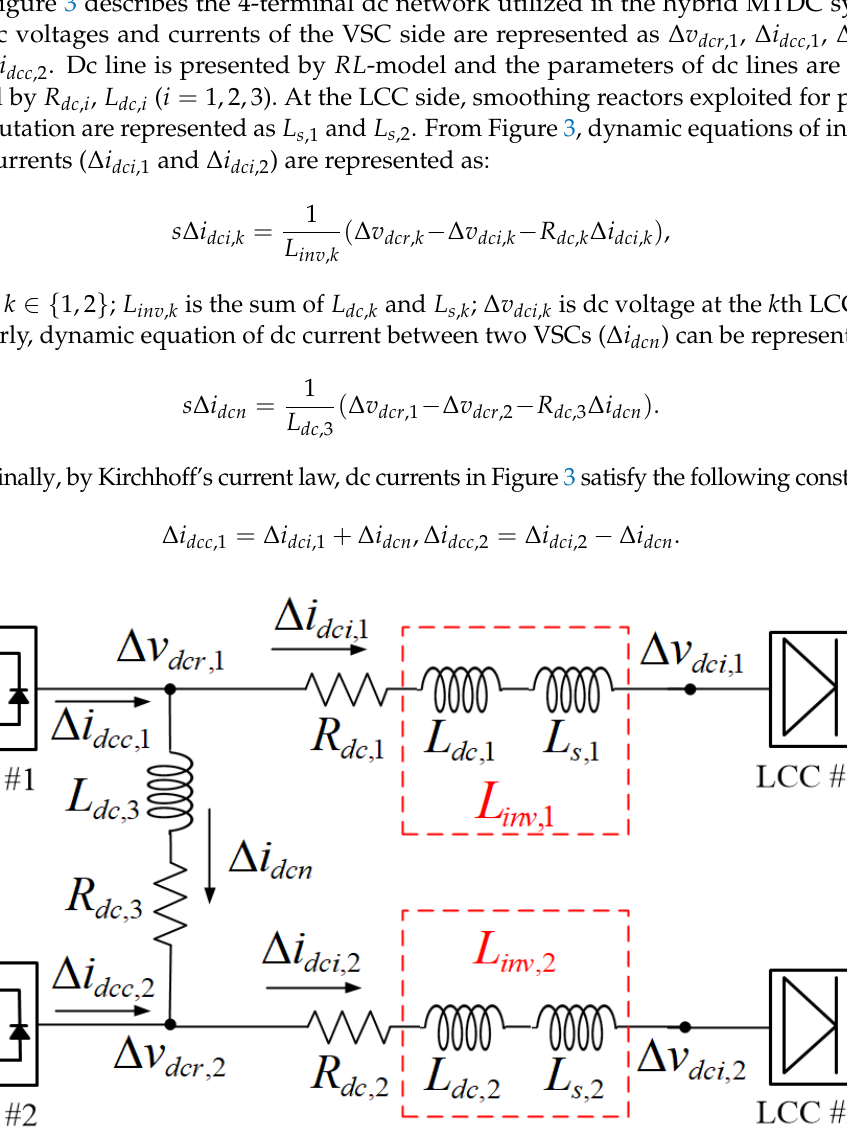
Figure 3. A configuration of a 4-terminal dc network